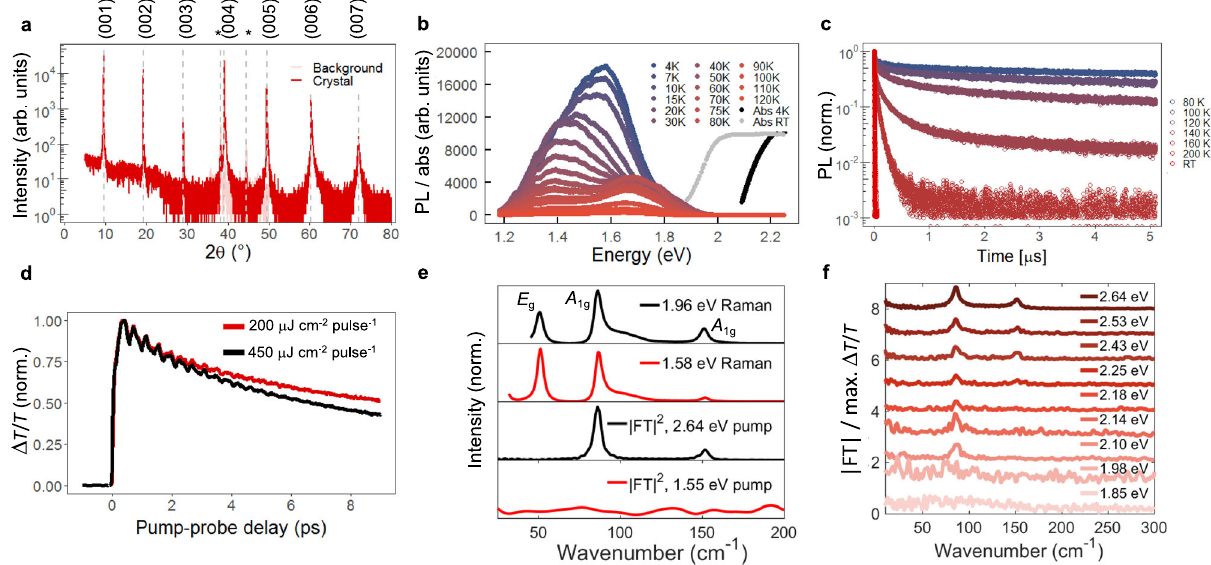
Fig. 1 | Material properties of BiOI single crystals. a X-ray diffraction (XRD) pattern of a BiOI single crystal plotted on top of the measured background. The vertical lines correspond to the (00 l ) re fl ections of the BiOI XRD pattern. b Temperature-dependent photoluminescence (PL) spectra of BiOI single crystals (532nm wavelength cw excitation) from 4K (dark blue) to 120K (bright red), together with the absorption spectra (Abs) at 4K (black) and room temperature (grey). c Decay of the PL over time, measured using time-correlated single photon counting (TCSPC) from 80K (dark blue) to room temperature (bright red). d Normalised differential transmission ( Δ T / T ) of BiOI thin fi lms after a 2.64eV pumppulseasafunctionofa2.07eVprobedelay,depictedfora200 μ Jcm − 2 pulse − 1